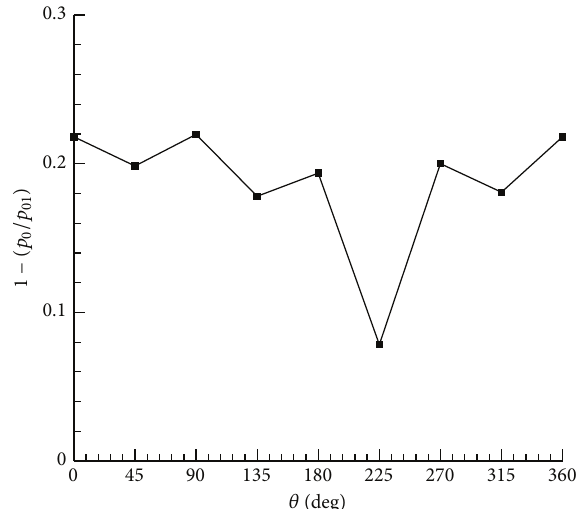
Figure 8: Variation of average Mach number 𝑀 3 as a function of total pressure loss for different values of inlet Mach number ( 𝑀 1 ) with 𝛿 M 1 = 0.05 obtained by inviscid analysis.